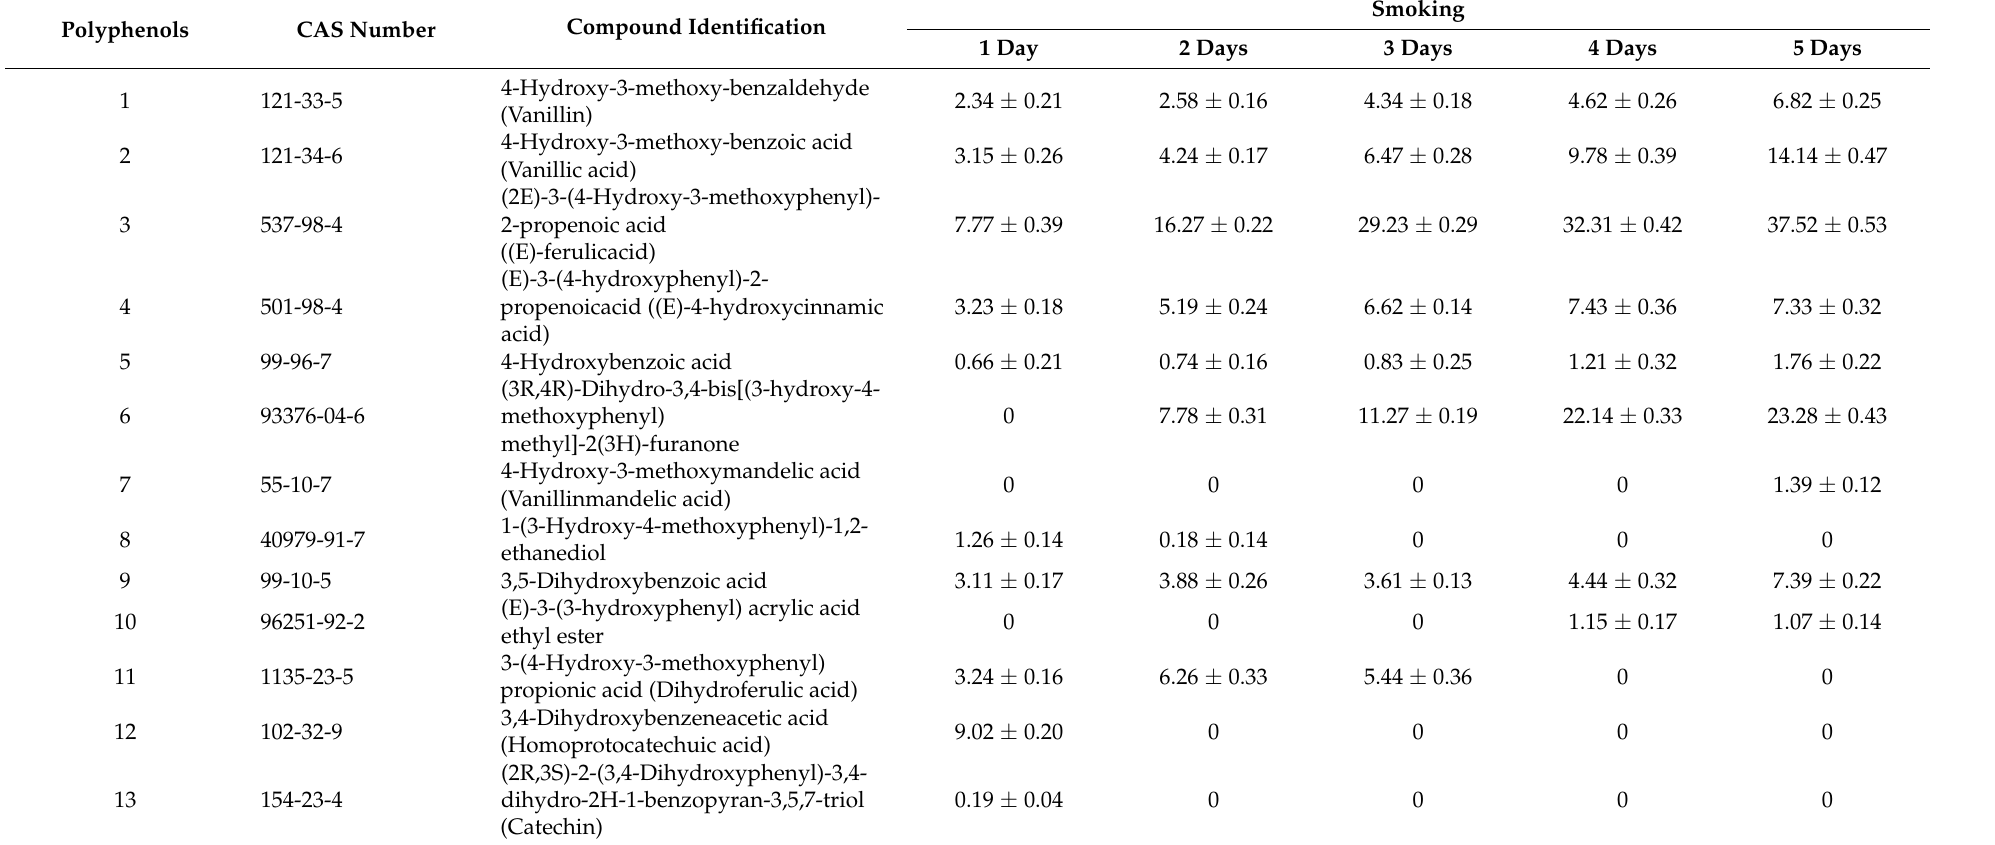
Table 3. Effect of in situ regulation on the distribution of polyphenols during the smoking process of Shanxi aged